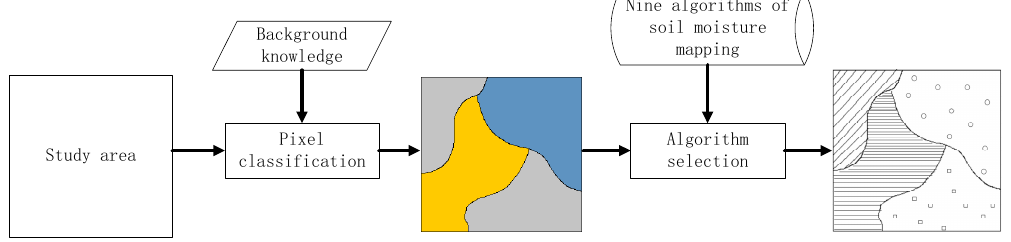
Figure 5. Schematic of the optimal solution method based on a specific background knowledge. Color: pixel classification results; Pattern: soil moisture results after mosaic.